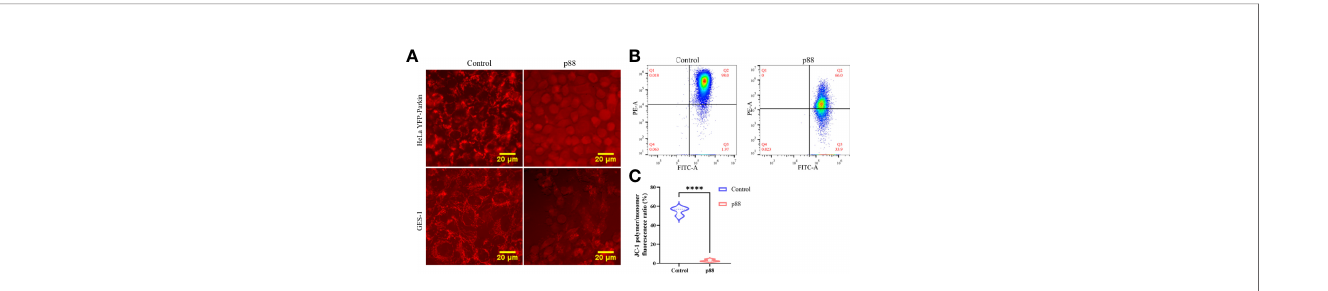
FIGURE 5 | p88 induces the decrease of the mitochondrial membrane potential (MMP) in GES-1 cells. Representative fl uorescence photographs (Scale bar, 20 m m) of the MMP in HeLa YFP-Parkin and GES-1 cells treated with p88 (12 m g/ml) for 1 h (A) . Representative the MMP photographs of p88-treated GES-1 cells were detected by fl ow cytometry with JC-1 (B) . Quantitative analysis of the MMP level in GES-1 cells treated with p88 was performed by the fl uorescence ratio of JC-1 polymer/monomer (C) . n = 3. **** p